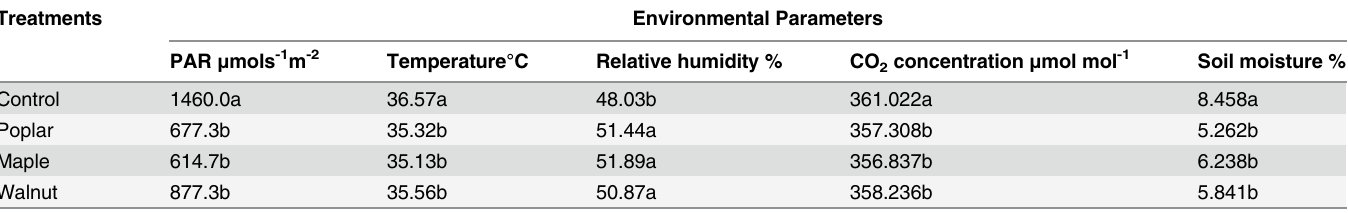
Table 4. Differences in a variety of environmental parameters measured (2012) in three intercropping treatments and monoculture control 26 (2012) years after establishing poplar, maple and walnut intercropping systems. Treatments